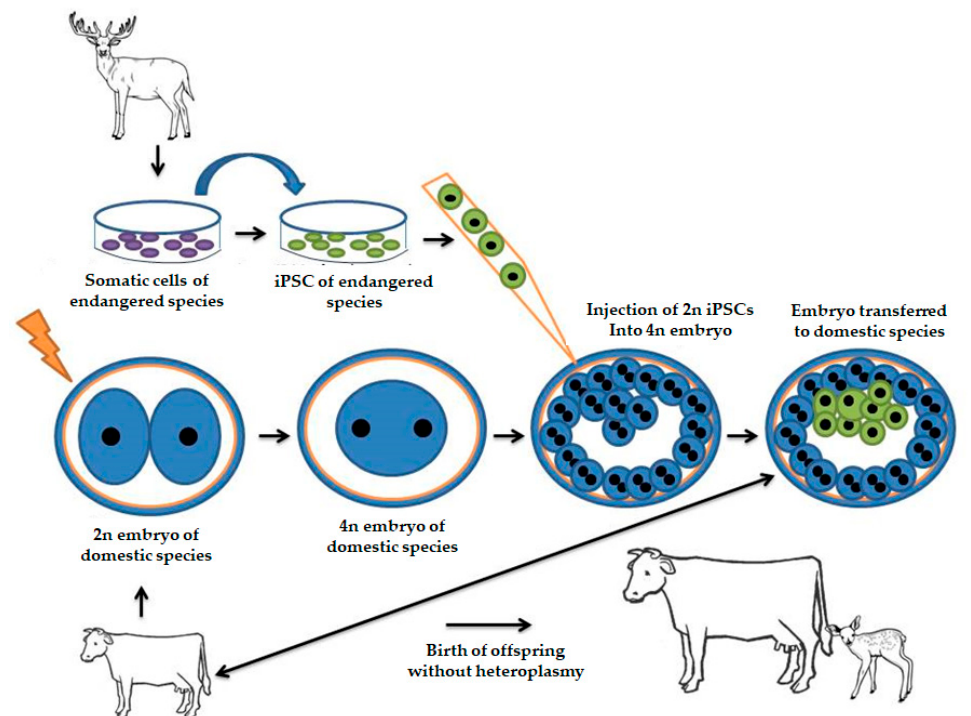
Figure 7. Scheme for production of individuals by the tetraploid complementation system. Somatic cells from wild species are reprogrammed into iPSC and inoculated in a tetraploid embryo of a domestic species. Tetraploid cells may give rise only to fetal attachments and iPSC cells to the fetus. Thus, there will be efficient maternal–fetal recognition after transferring the embryo to the recipient of the domestic species, and the offspring produced would not have the heteroplasm that is observed in the iSCNT.